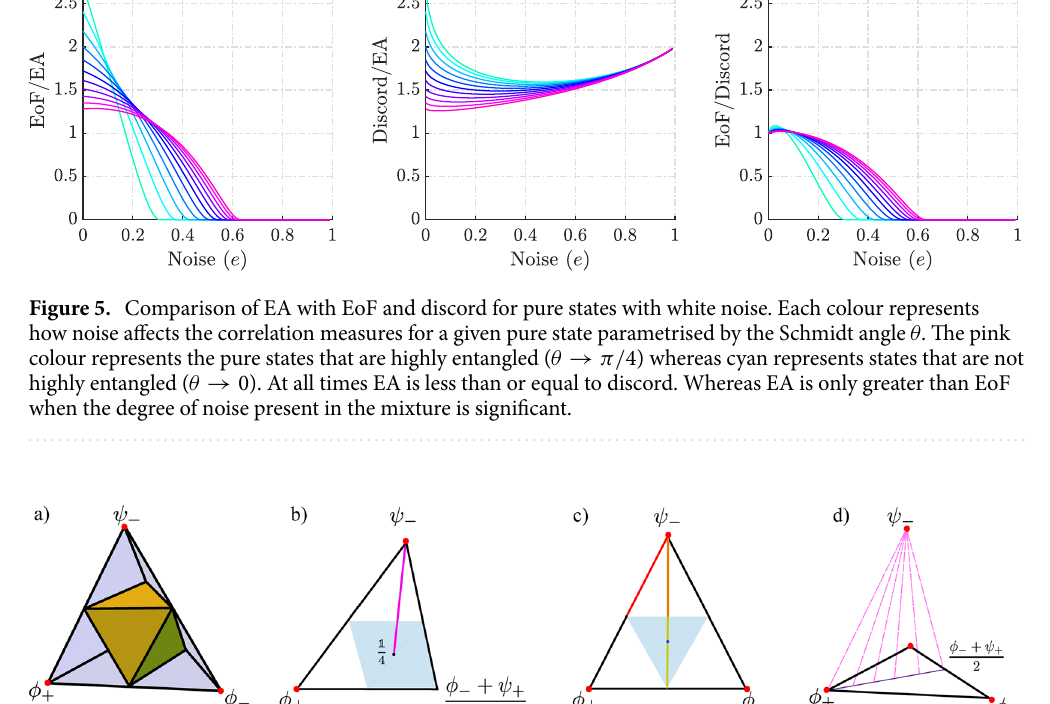
3 1 . The region outside the c j 1 j ≤ = (cid:30) (cid:30) (cid:31) (cid:30) (cid:30) and face −